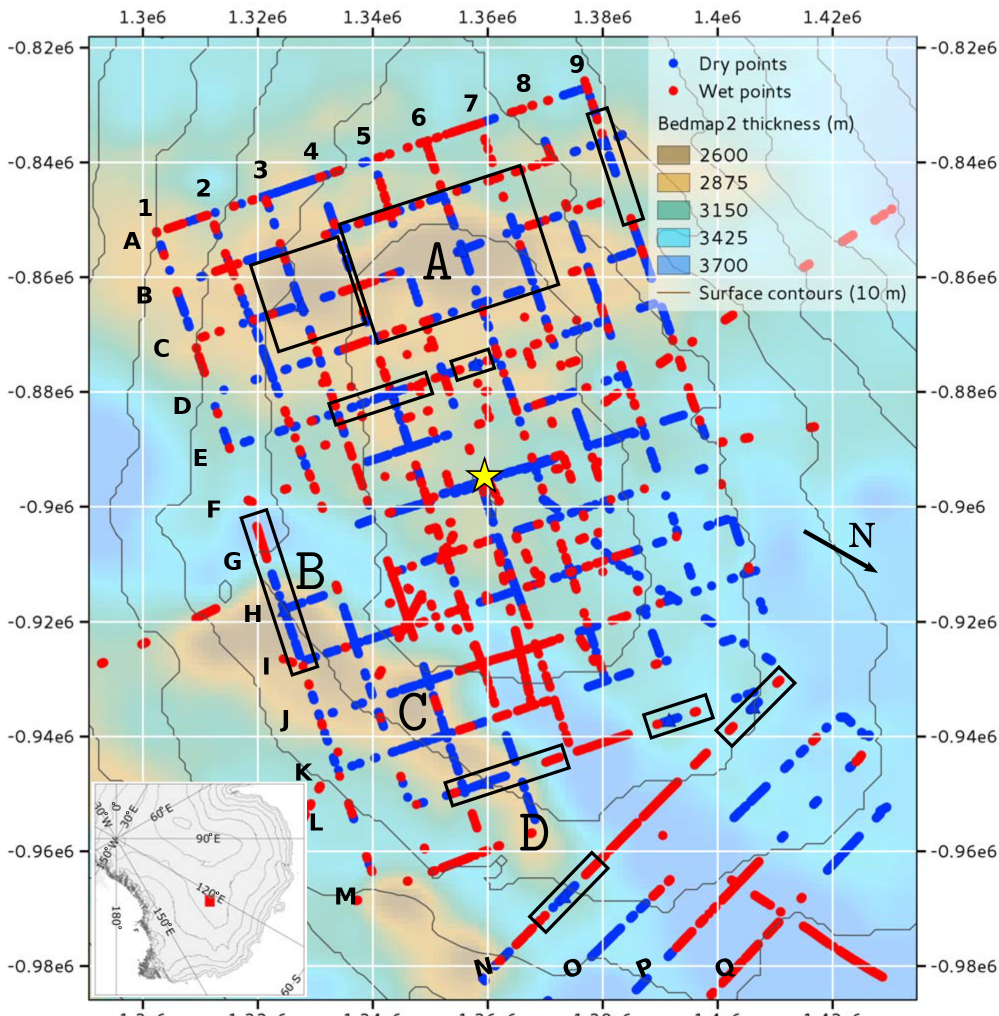
Figure 1. Wet (red) and dry (blue) bed conditions, adapted from Zirizzotti et al. (2012). The yellow star shows the EPICA drill site, located at a distance of 1 . 4km from the topographic dome. Side numbers and letters locate intersection points on the radar grid. Large letters identify for the main sites of interest (candidates A , B , C and D ). Projection: WGS84/Antarctic Polar Stereographic – EPSG:3031 (metres). The north direction is bottom right. The situation map on the bottom left shows the position of our domain (red